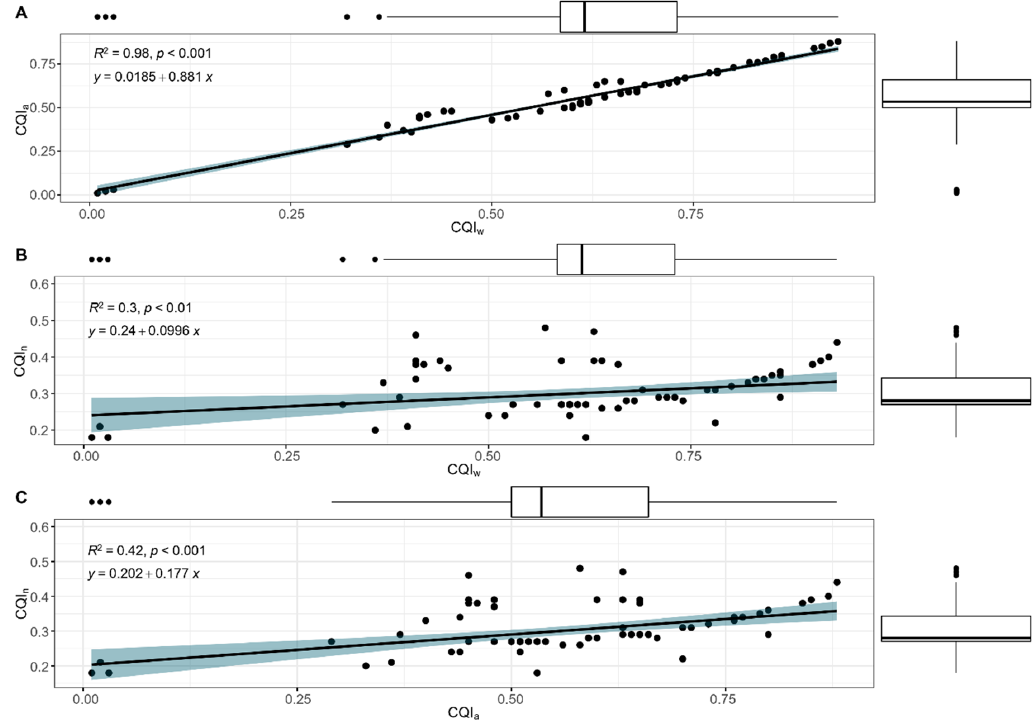
Figure 13. Linear correlation between developed CQIs; gray area represents the 95% CI ( A – C )